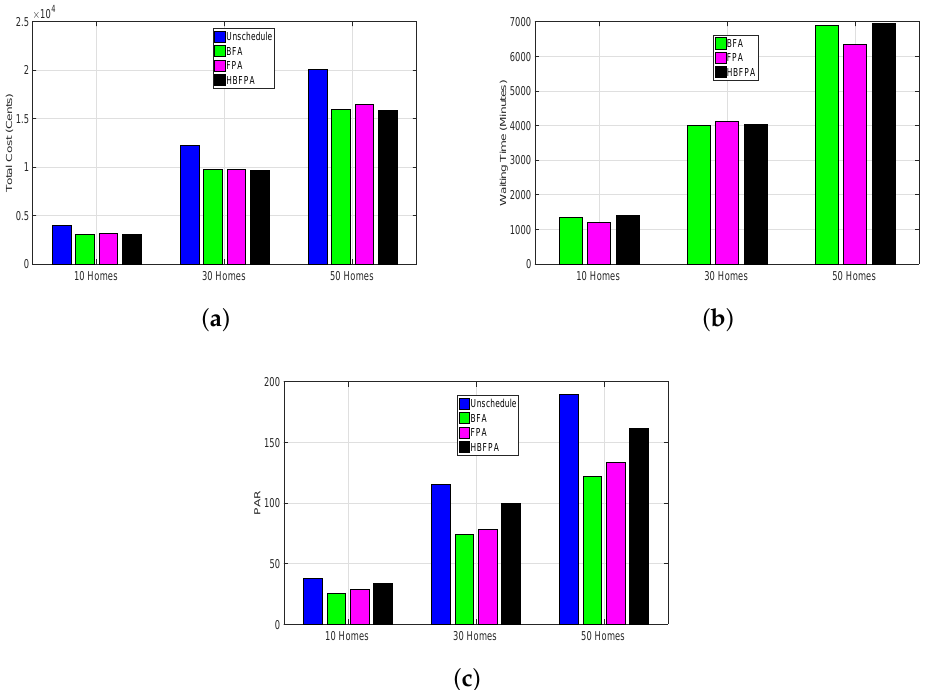
Figure 15. Electricity cost, waiting time and peak to average ratio for multiple homes: (10, 30 and 50) using real time pricing. ( a ) Electricity cost using operational time interval of 60 min; ( b ) Waiting time using operational time interval of 60 min; ( c ) Peak to average ratio using operational time interval of 60 min. Table 21. Electricity cost for 24 h (for multiple homes).